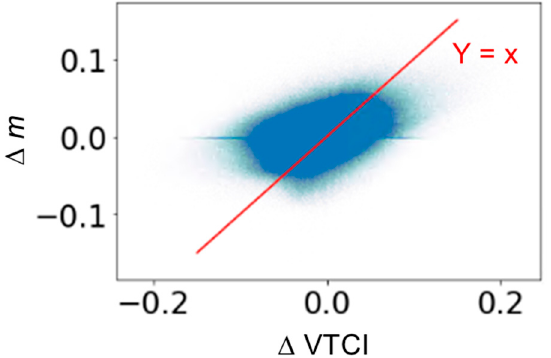
Figure 9. Comparison of daily fuel moisture increment calculated by FFMC and VTCI.